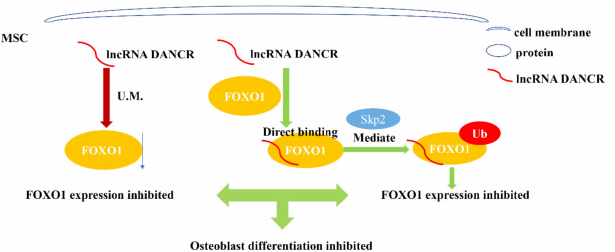
Figure 3. Schematic illustration of lncRNA DANCR regulating osteoblast differentiation of MSC by directly binding to protein FOXO1. Through unknown mechanisms, DANCR inhibits FOXO1 expression. Additionally, DANCR directly binds to FOXO1 and promotes Skp2-mediated ubiquitina- tion of FOXO1, which further reduces FOXO1 expression. FOXO1, a transcription factor, regulates proliferation, differentiation and apoptosis of osteoblasts. By decreasing FOXO1 expression, DANCR ultimately inhibits osteoblast differentiation of MSC. U.M., unknown